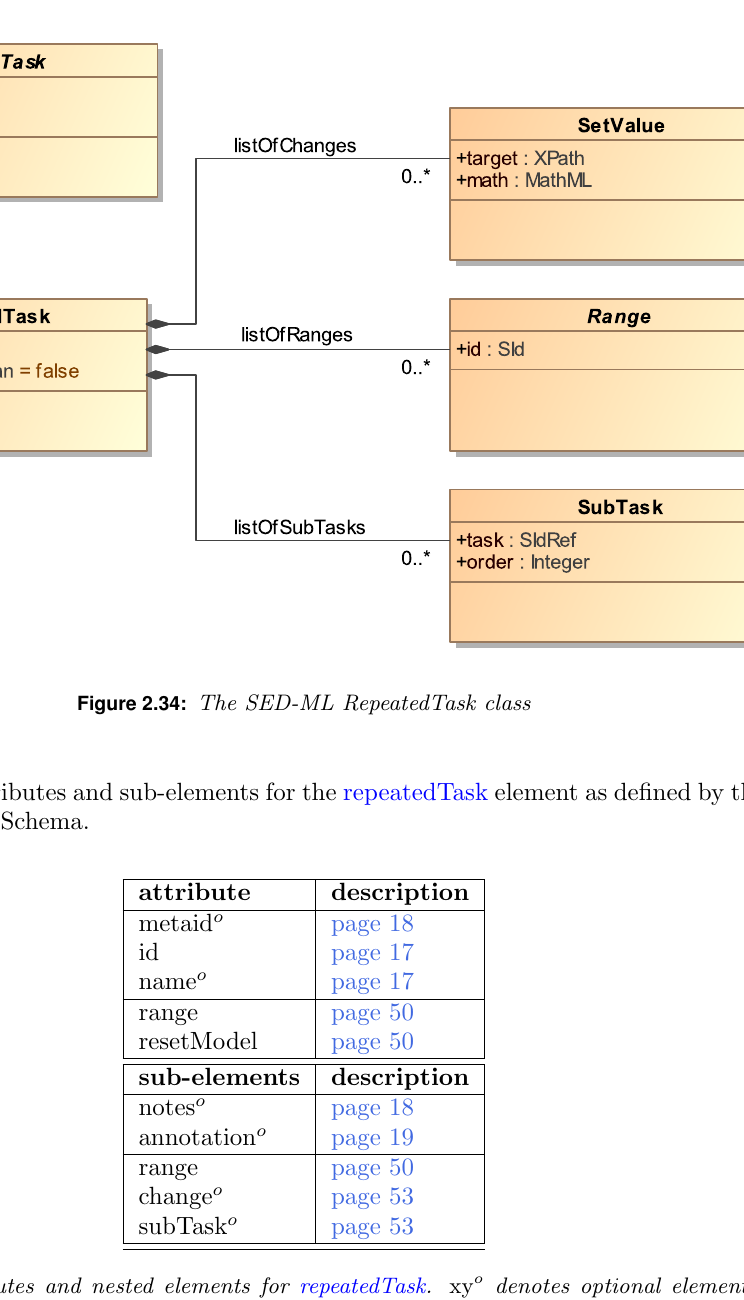
Table 2.22: Attributes and nested elements for repeatedTask. xy o denotes optional elements and